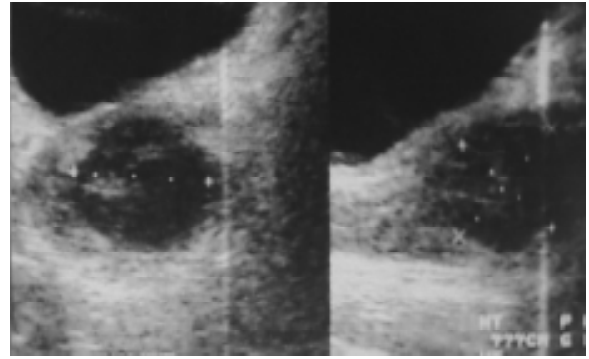
Figure 1 – Prostatic transrectal ultrasonography showing the prostatic abscess.